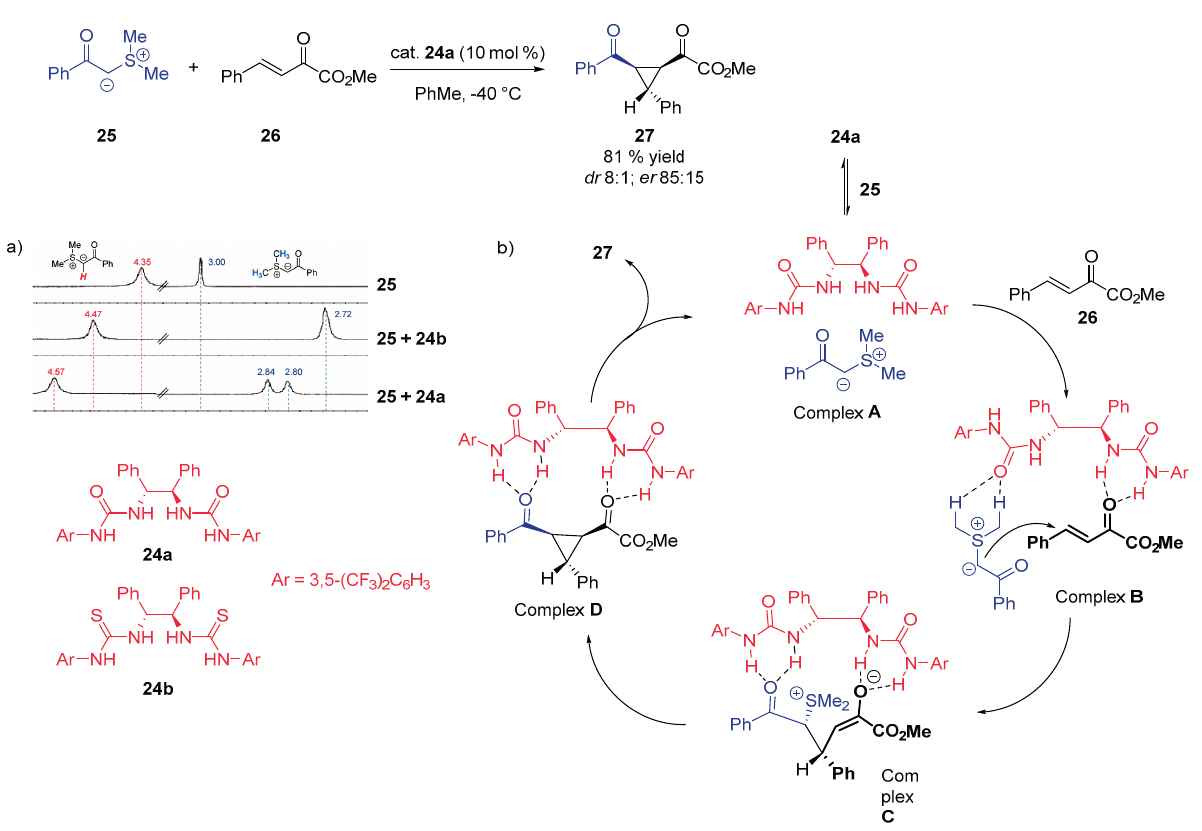
Figure 7. The downfield shift of 1 H-NMR signal for C–H of sulfur ylide 25 after complex formation with 24a and 24b ( a ); proposed catalytic cycle for asymmetric cyclopropanation ( b ). Adapted with permission from Ref. [32]. Copyright (2011) American Chemical